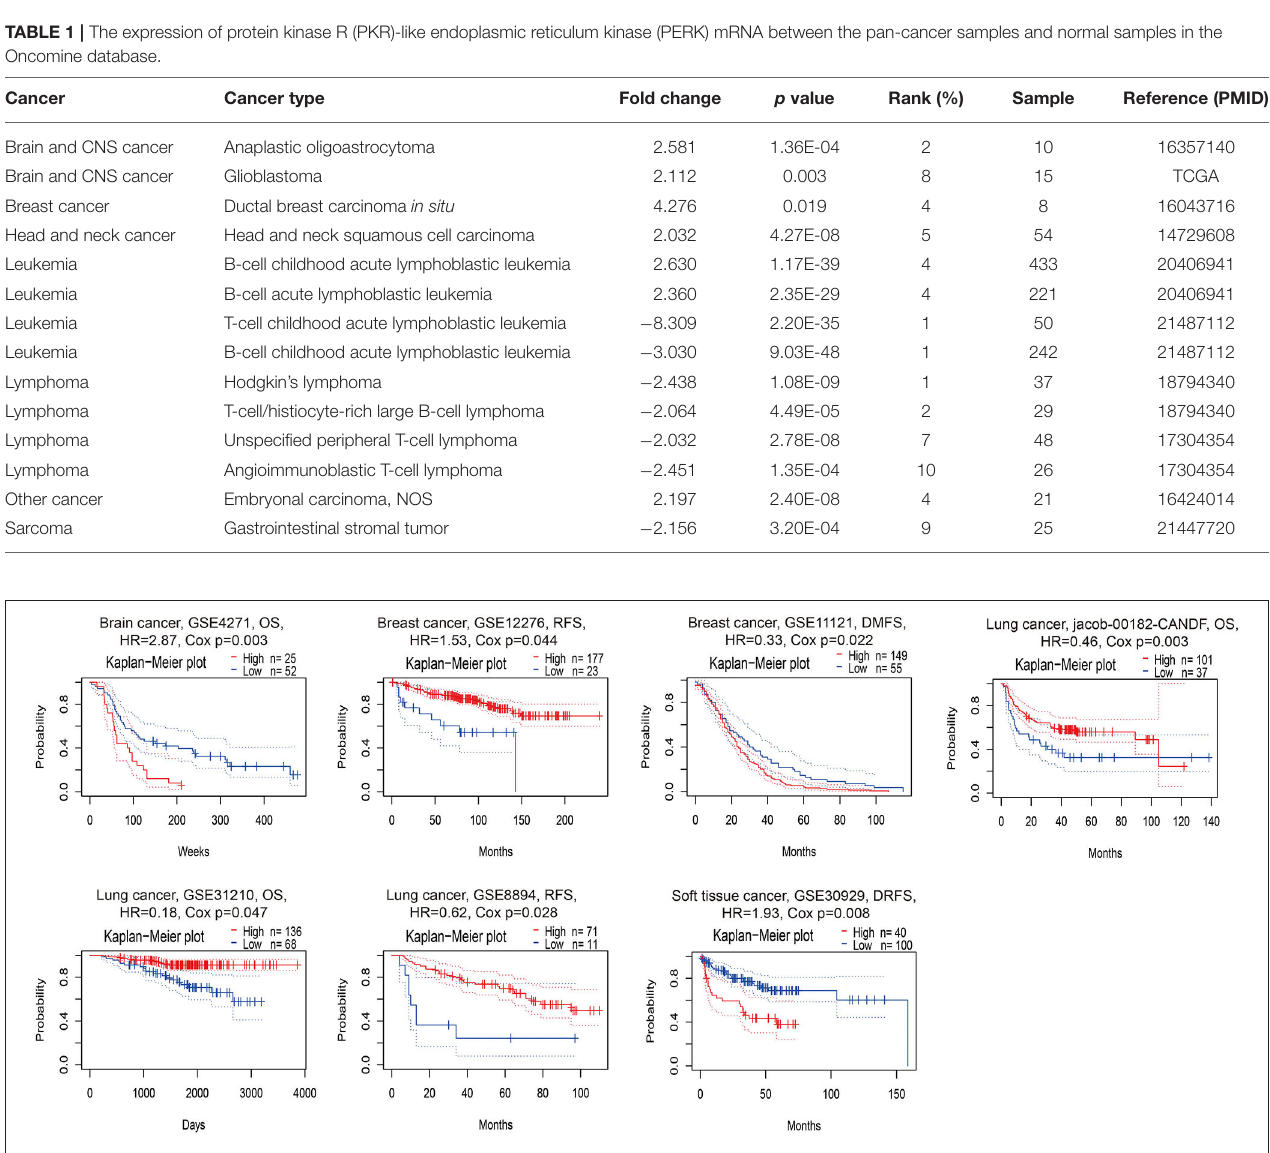
FIGURE 3 | Kaplan–Meier survival curves comparing the high and low expressions of PERK in different cancer types in PrognoScan. DSS, disease-specific survival; OS, overall survival; DMFS, distant metastasis-free survival; DFS, disease-free survival; RFS, relapse-free